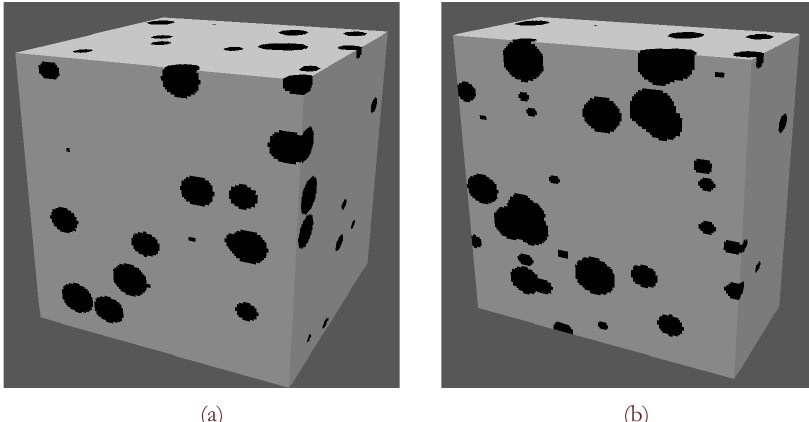
Figure 12: The 3D generated structural model of the ceramic composite with 15% contain of the hardening particles: the whole specimen (a) and a middle clip (b).